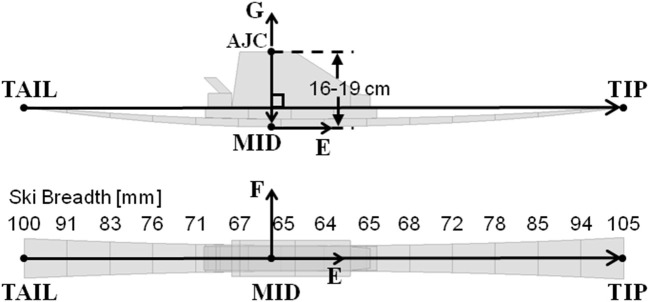
The 15 segment ski model fitted to TIP, TAIL, and AJC. MID was defined as the point along the ski sole 16–19 cm below AJC, in the direction perpendicular to the TIP-TAIL vector.